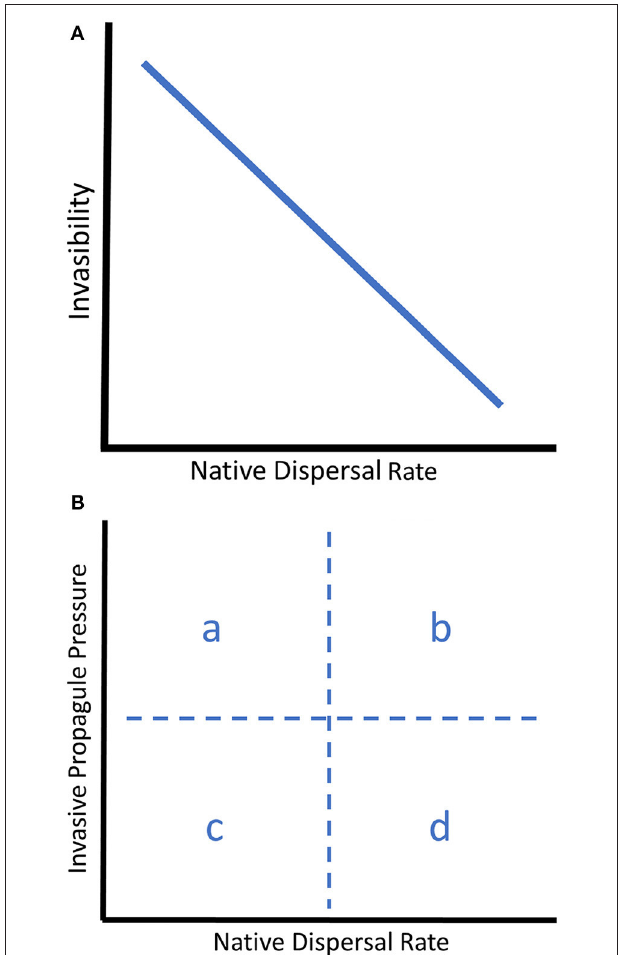
FIGURE 3 | Hypothesized relationships between dispersal and invasibility. (A) Hypothesized effect of native dispersal rate of species in a community on the invasibility of that locality. (B) Four invasion scenarios defined by propagule pressure of a potential invader and dispersal rates of native species. Scenario a represents the highest potential for invasion while scenario d represents the lowest potential for invasion. Scenarios b and c have intermediate potential for invasion and specific outcomes will largely depend on specifics of the local